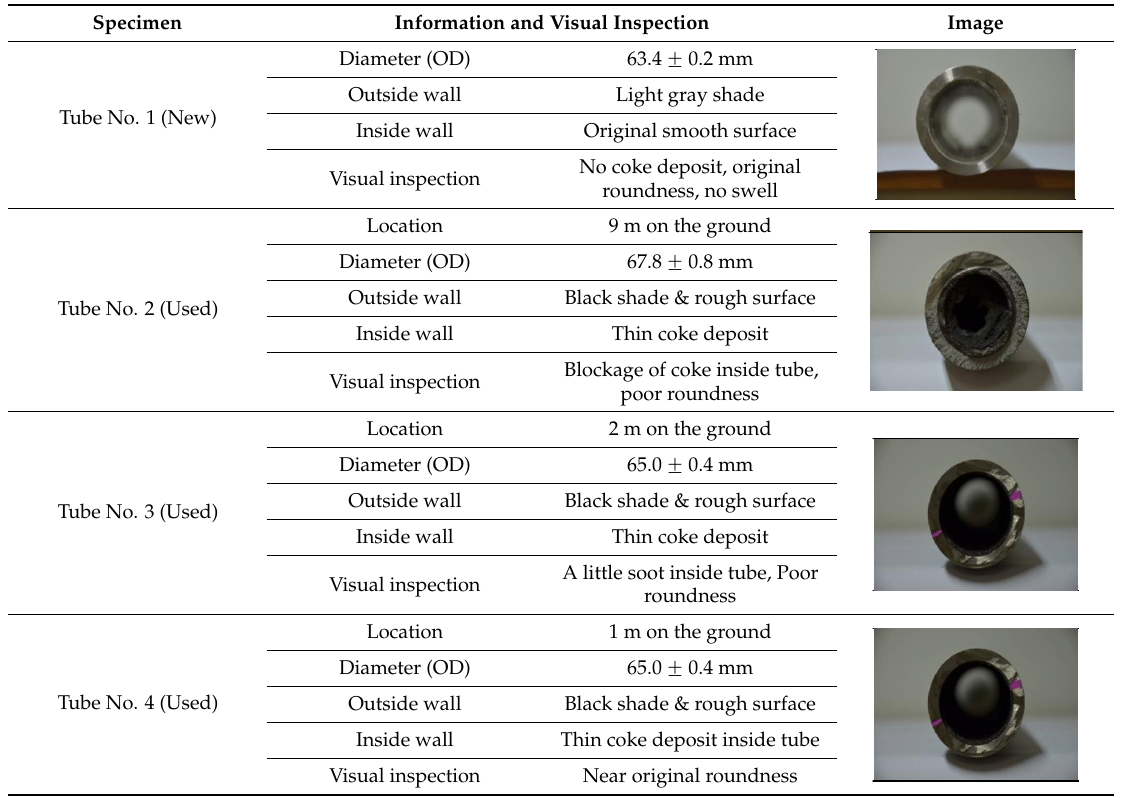
Table 2. Heat treatment conditions.